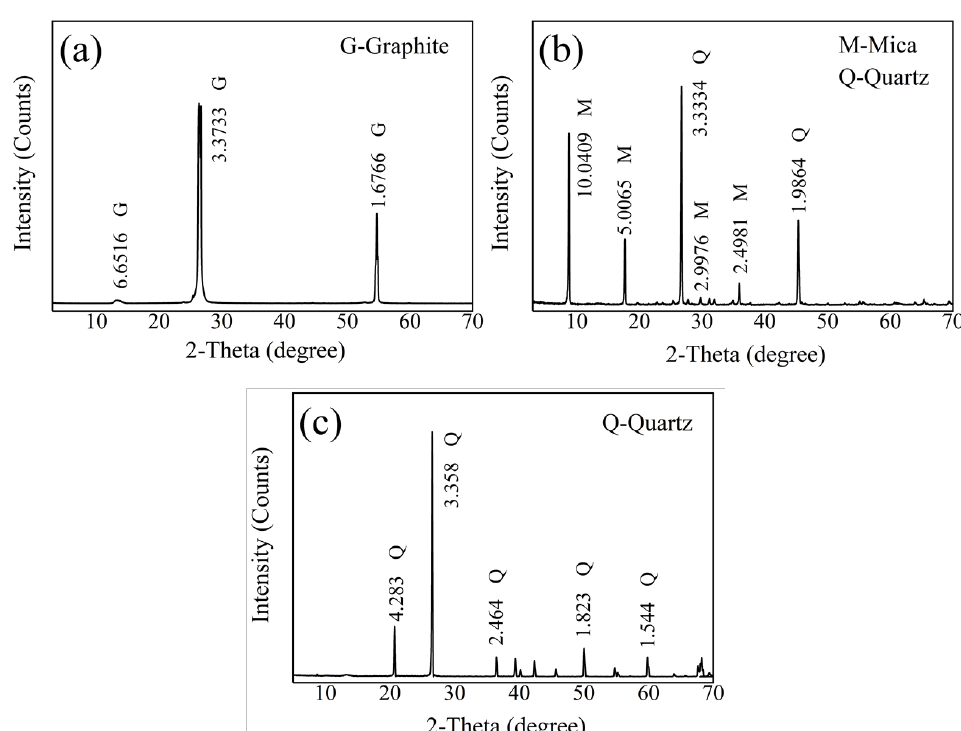
Figure 2. XRD spectra of the test samples: ( a ) graphite; ( b ) mica; and ( c ) quartz.